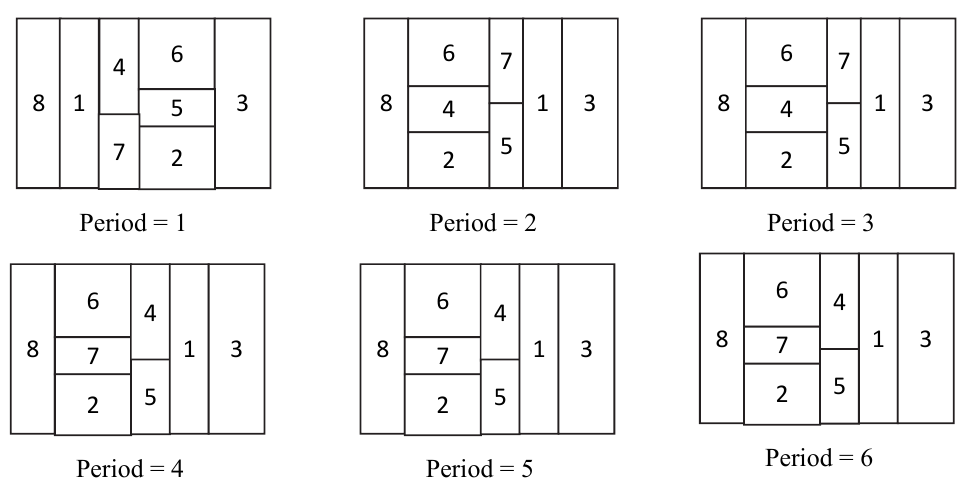
Fig. 8. (a). Best soltion for FBS-DFLP-3, M =